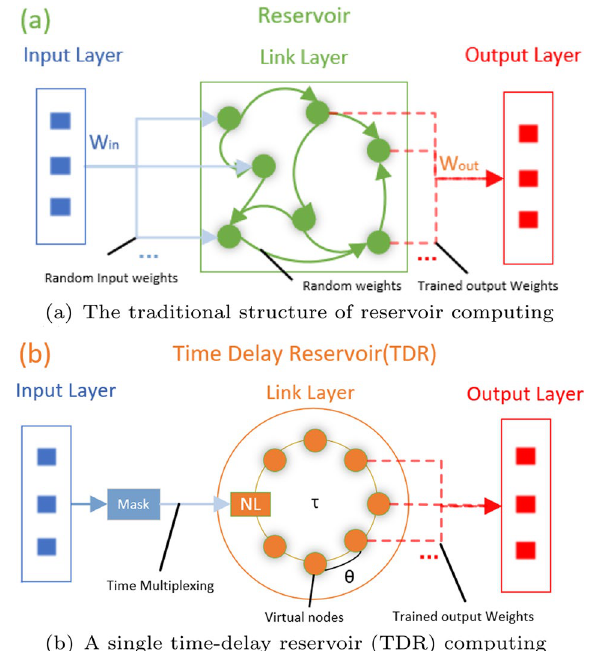
Fig. 1 Basic structure of traditional RC and TDR